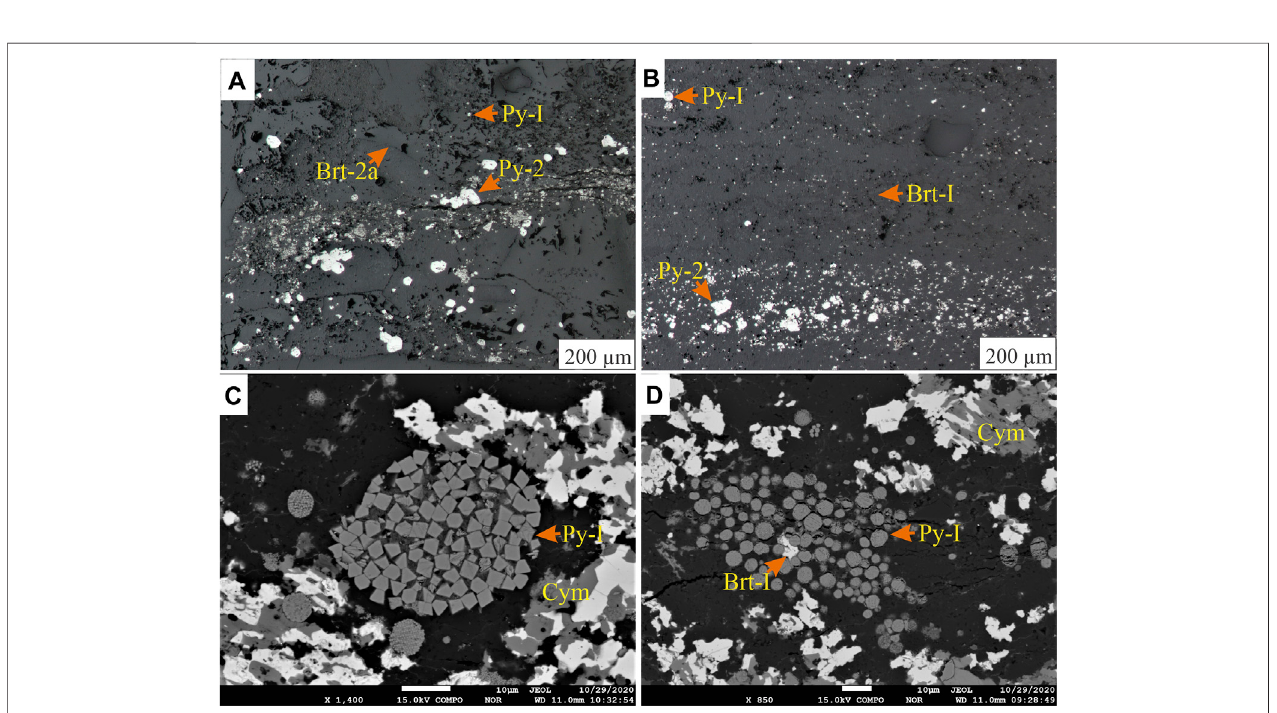
FIGURE 6 | Re fl ected light and backscatter electron (BSE) images of pyrite and barite generations. (A) Re fl ected light image showing pyrite framboids (Py-1) in intra-andintergranularporesspacesofbarite(Brt-2a)andclaymatrix.Pyrite(Py-2)isobservedtobedisseminatedwithinthematrixandinandaroundinterlockinggrains of laminated barite (Brt-2a). (B) Re fl ected light image of stratiform pyrite (Py-2) in clay lamination with microcrystalline barite (Brt-1) and pyrite framboids (Py-1). (C) BSE image of pyrite framboids (Py-1) of variable sizes and nanocrystal morphologies within carbonaceous mudrock matrix. (D) BSE image of Py-1 framboids and polyframboids with disseminated microcrystalline barite (Brt-1) and replaced mainly by cymrite (Cym).